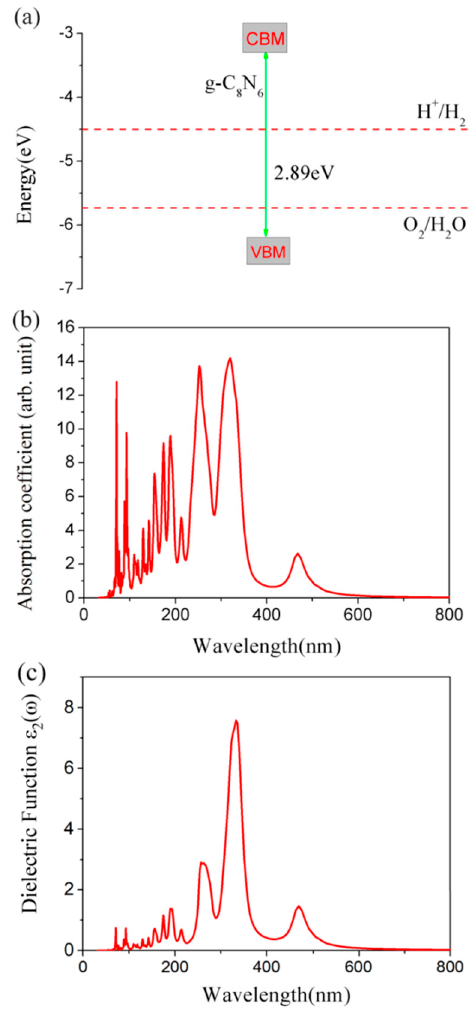
Figure 3. ( a ) Band alignments of g–C 8 N 6 with respect to the standard water redox potentials; ( b ) absorption coefficient and ( c ) imaginary part of the dielectric function (in-plane polarization) for g–C 8 N 6 using HSE06 method.